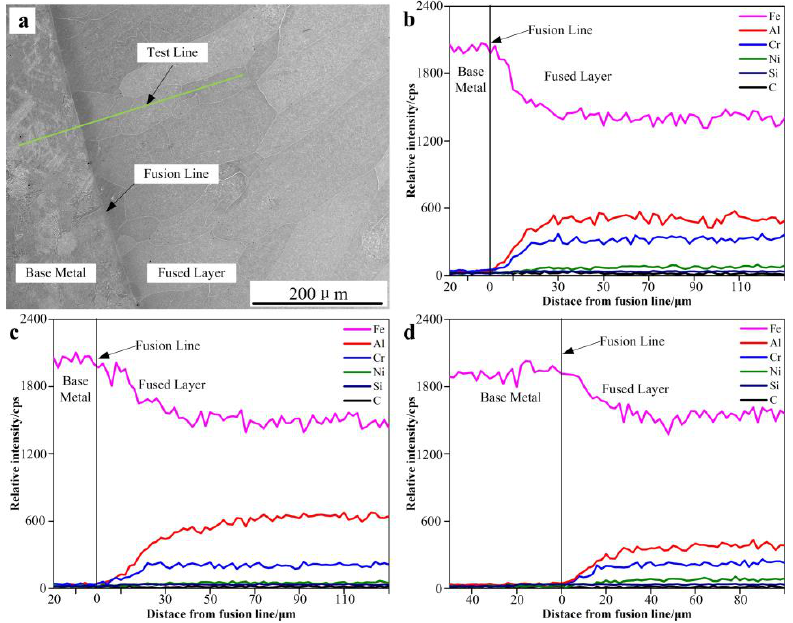
Figure 4. Energy-dispersive X-ray spectrometry (EDS) results: ( a ) the scanning positon; ( b ) I: CC 0.2 m/min; ( c ) II: CC 0.3 m/min; and, ( d ) III: PC 0.2 m/min.